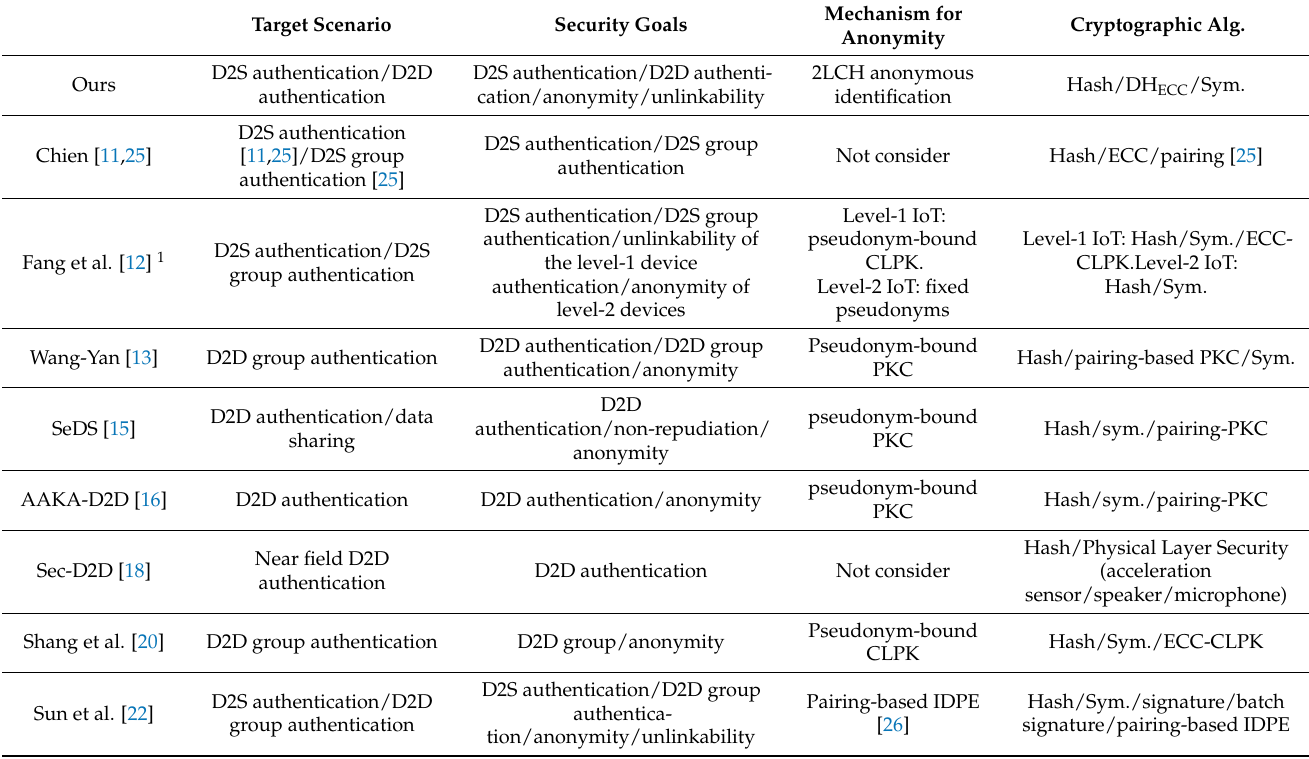
Table 3. Brief summary of the targeted scenarios and the security goals of D2S/D2D authentication